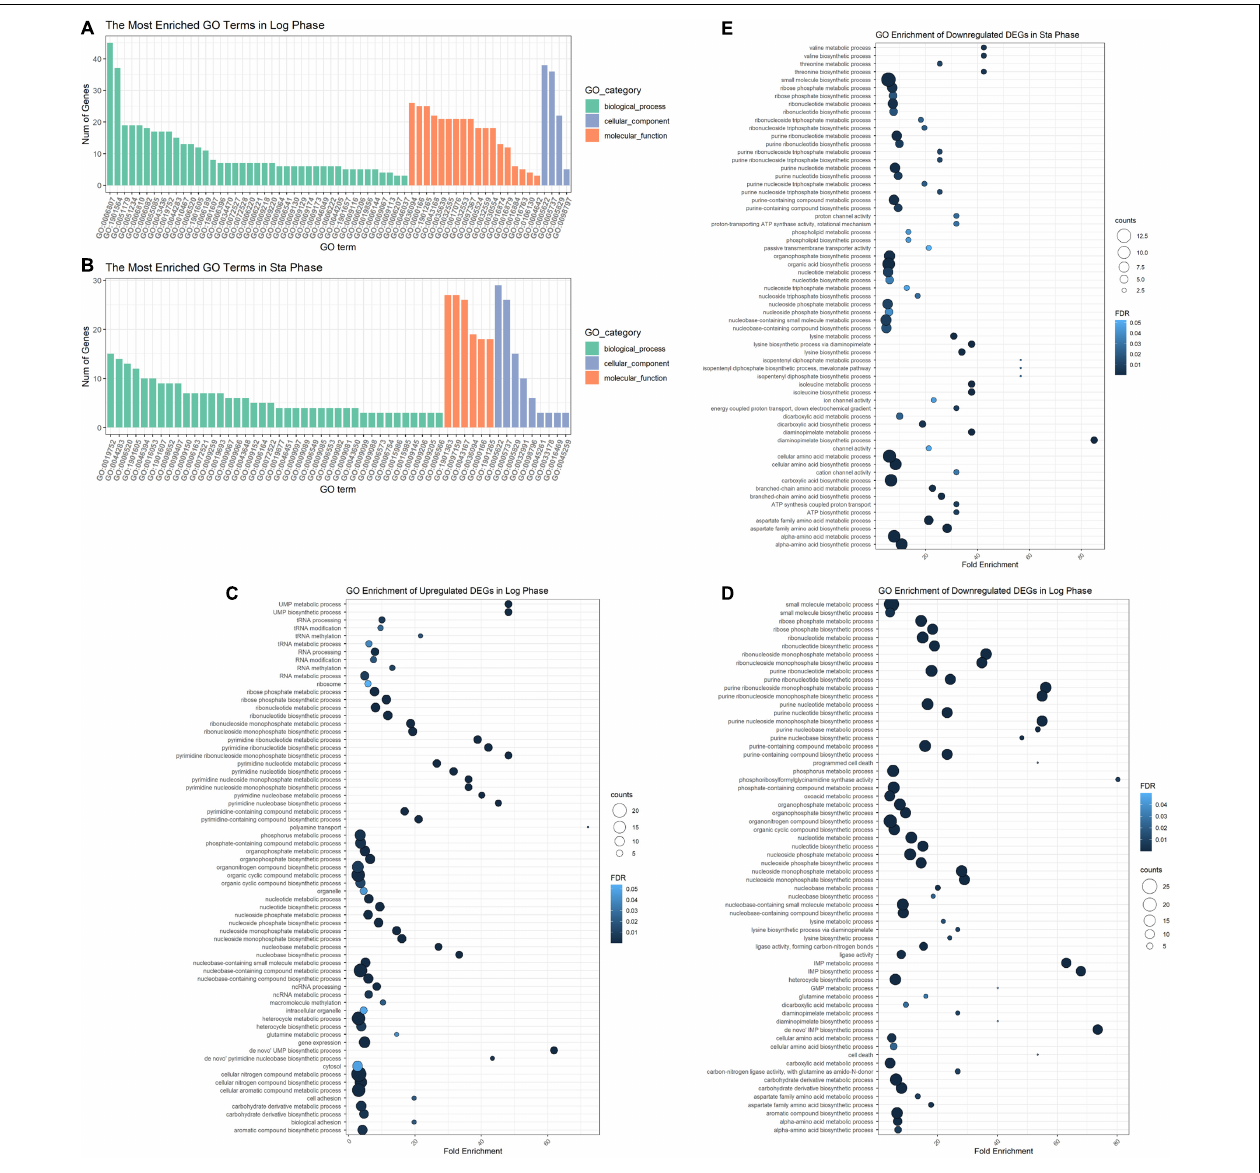
FIGURE 7 | GO enrichment analysis of DEGs. GO analysis divided DEGs of the logarithmic phase (A) and stationary phase (B) into three functional groups: biological processes, molecular function, and cellular component. GO enrichment significance items of upregulated (C) and downregulated genes (D) during the logarithmic phase, and downregulated genes during the stationary phase (E) . DEGs, differentially expressed genes; GO, gene